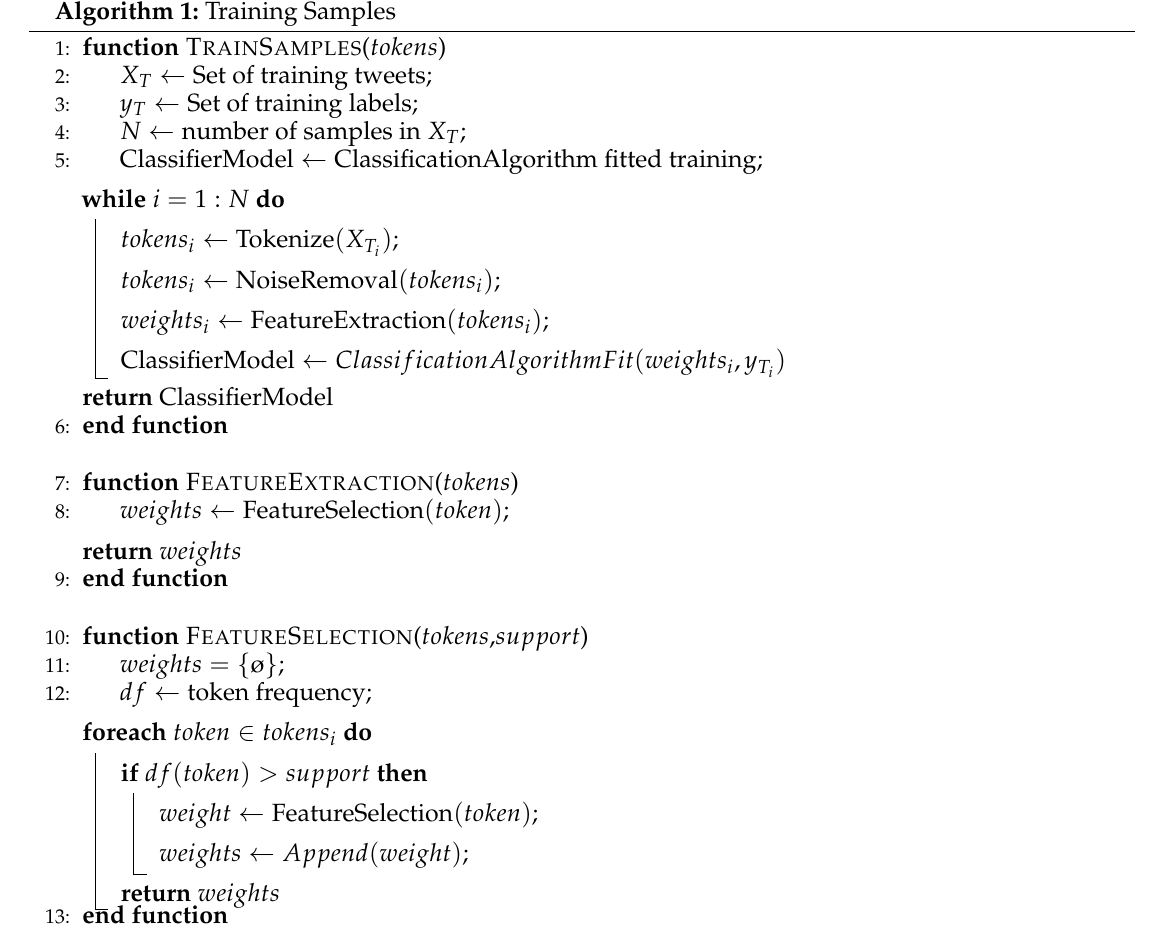
Algorithm 1: Training